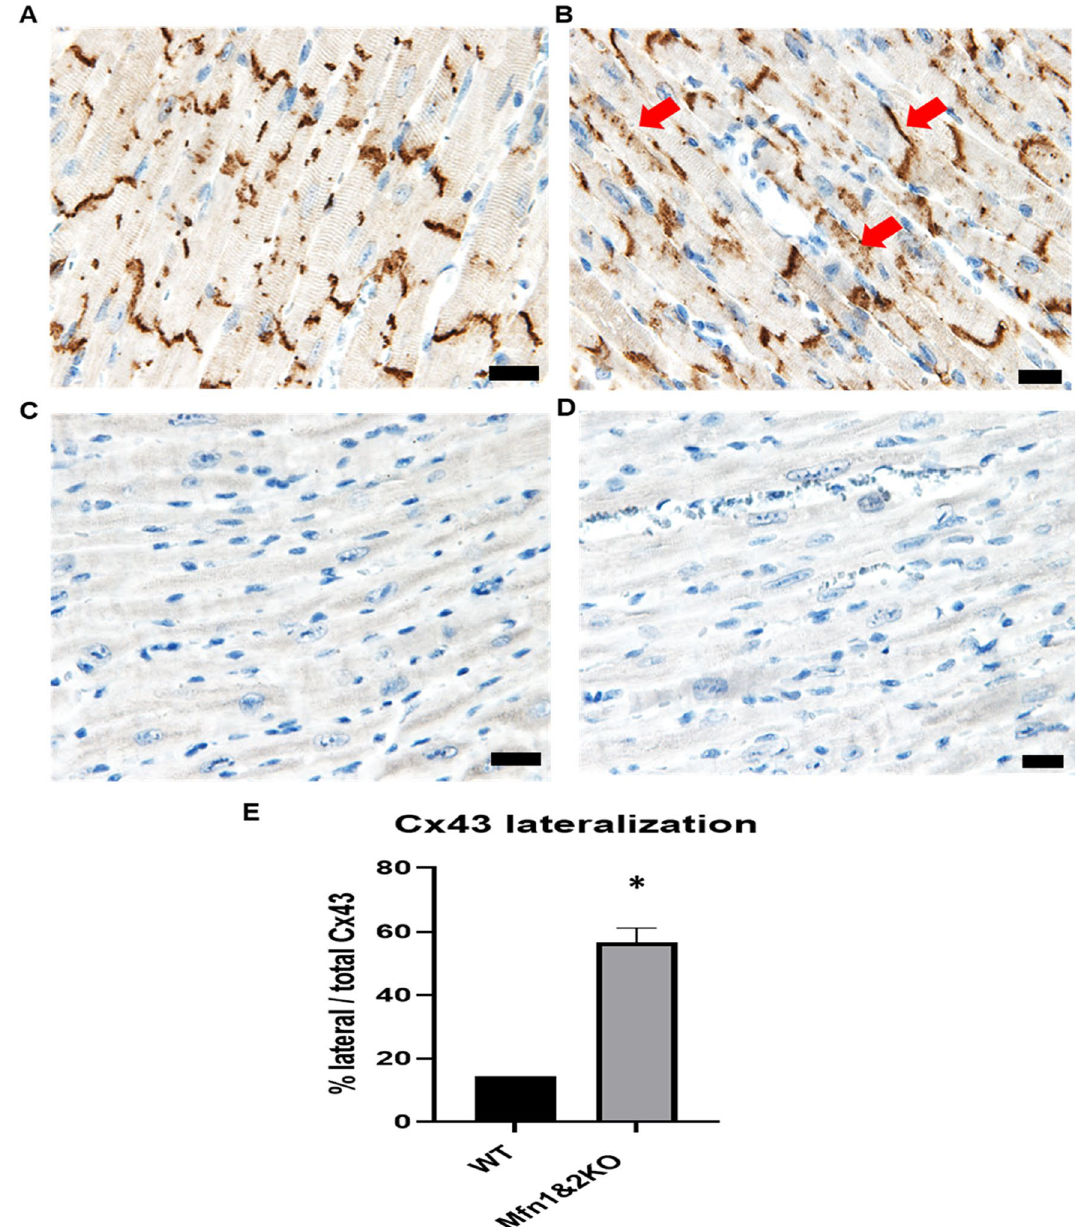
Figure 4. Lateralization of Cx43 in the Mfn-DKO hearts. Cross-sections of left ventricle from 8-weeks-old males, ( A ) WT control versus ( B ) Mfn-DKO, cardiac-specific, transgenic mice, immuno-stained with anti-Cx43 (brown). Examples of lateralised regions of Cx43 are delineated with red arrows. The negative controls using normal rabbit IgG and secondary antibody solely, without primary antibody, are represented by ( C,D ) respectively. Scale bar = 20 µm ( E ) Quantitative analysis of Cx43 lateralization. Images are representatives of 3 hearts for each group. Data are presented as mean ± SEM; *p < 0.05 when compared against